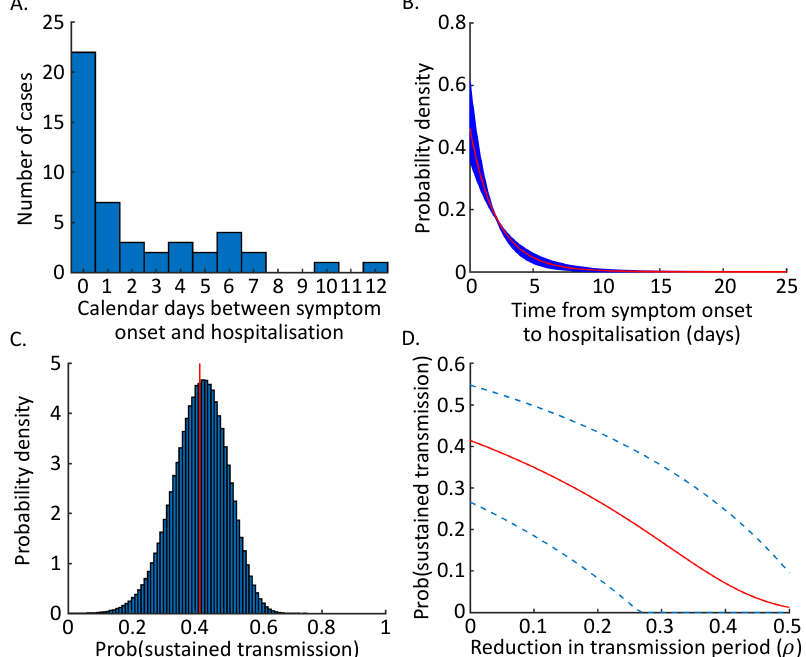
Figure 1. The probability of a self-sustaining outbreak driven by human-to-human transmission arising following the importation of one infected individual. ( A ) Data describing the number of days between symptom onset and hospitalisation for 47 patients in the ongoing outbreak [15]. ( B ) The estimated distribution of times between symptom onset and hospitalisation, obtained by fitting to the data shown in panel A. Blue lines show a range of equally possible distributions (see Methods; 50 distributions are shown here, selected at random from the n = 100,000 distributions considered), and the red line shows the average of the n = 100,000 distributions. ( C ) The probability of sustained transmission for each possible distribution of times from symptom onset to hospitalisation (Equation (1); blue histogram) and the probability of sustained transmission obtained by integrating over the possible distributions (Equation (2); red line). ( D ) The probability that a single imported case leads to sustained transmission in a new location, for di ff erent surveillance levels. The red line shows the mean estimates (obtained using Equation (2) but extended to account for intensified surveillance), and the blue dotted lines show the 5th and 95th percentile estimates (obtained when Equation (1) is applied, but extended to account for intensified